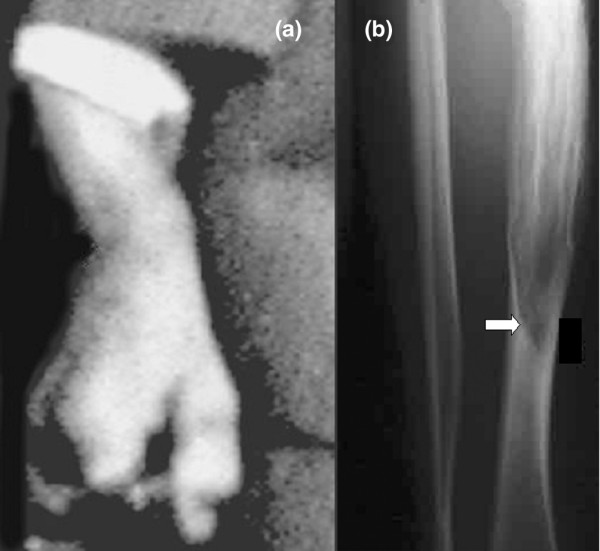
Evidence of PDB in two affected subjects from F01 family. (a) Bone deformity of the right forearm of family member II-3. Relatives described him as having suffered from multiple bone deformities and pain. (b) X-ray scan of the right tibia of family member III-3, with a typical flame-shaped lytic wedge (arrow).